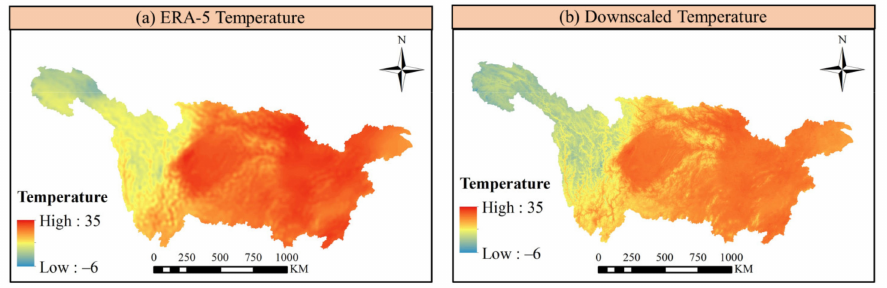
Figure 8. The spatial distribution of ERA-5 temperature and downscaled temperature in 1 July in YRB. Moreover, we mapped the spatial distributions of average downscaled temperature in each season in 2019 (Figure 9). The spatial patterns of downscaled temperature showed prominent seasonality and spatial heterogeneity in YRB. The overall temperature ranged from − 23 ◦ C to 30 ◦ C in 2019. Temporally, average temperature was significantly higher in summer (June to August) and lower in winter (December to February). Spatially, the downscaled temperature increased from the western YRB to the middle and lower regions of YRB. Location with lowest temperature lay in the Qinghai-Tibet Plateau, which had the highest elevation in the entire